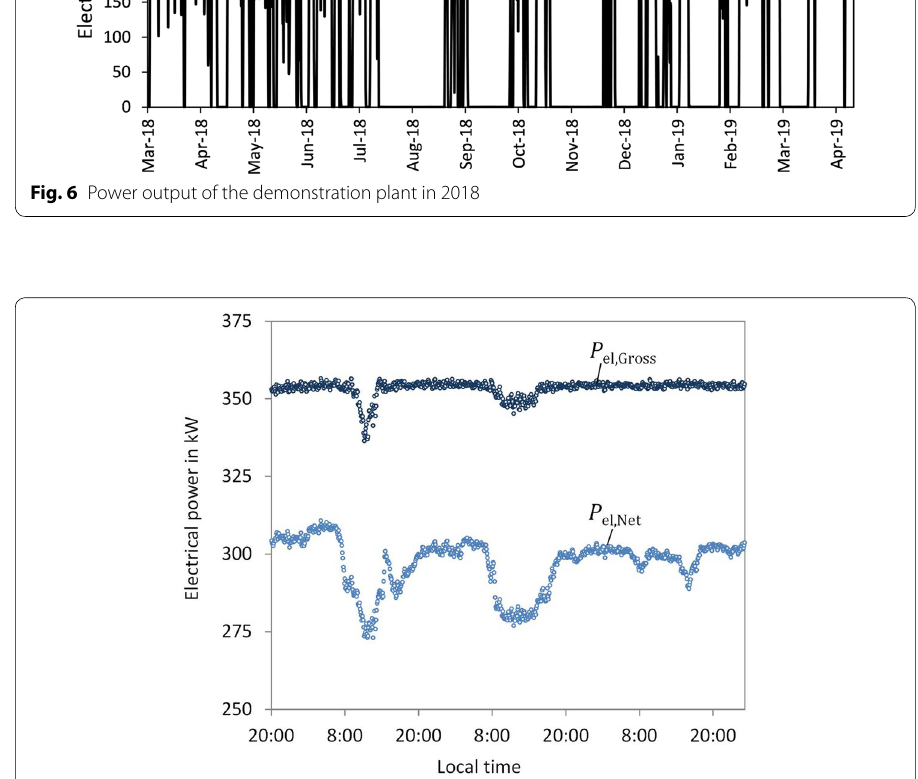
Fig. 7 Plant data for 48 h operation—gross and net power